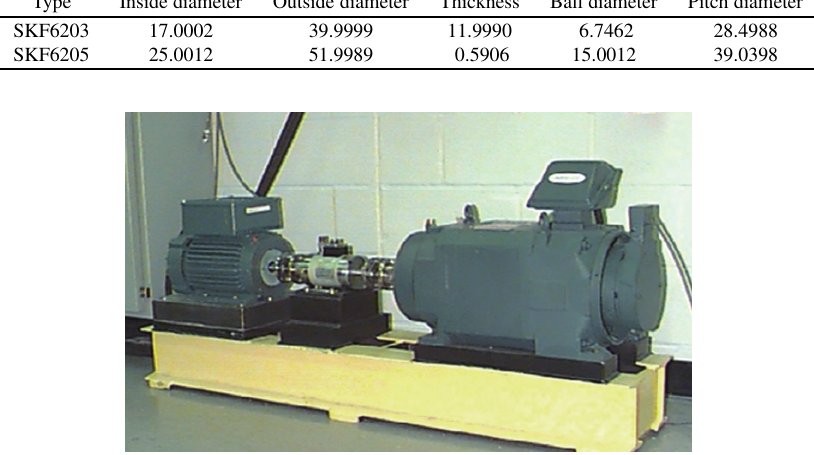
Fig. 4. Sketch map of the bearing